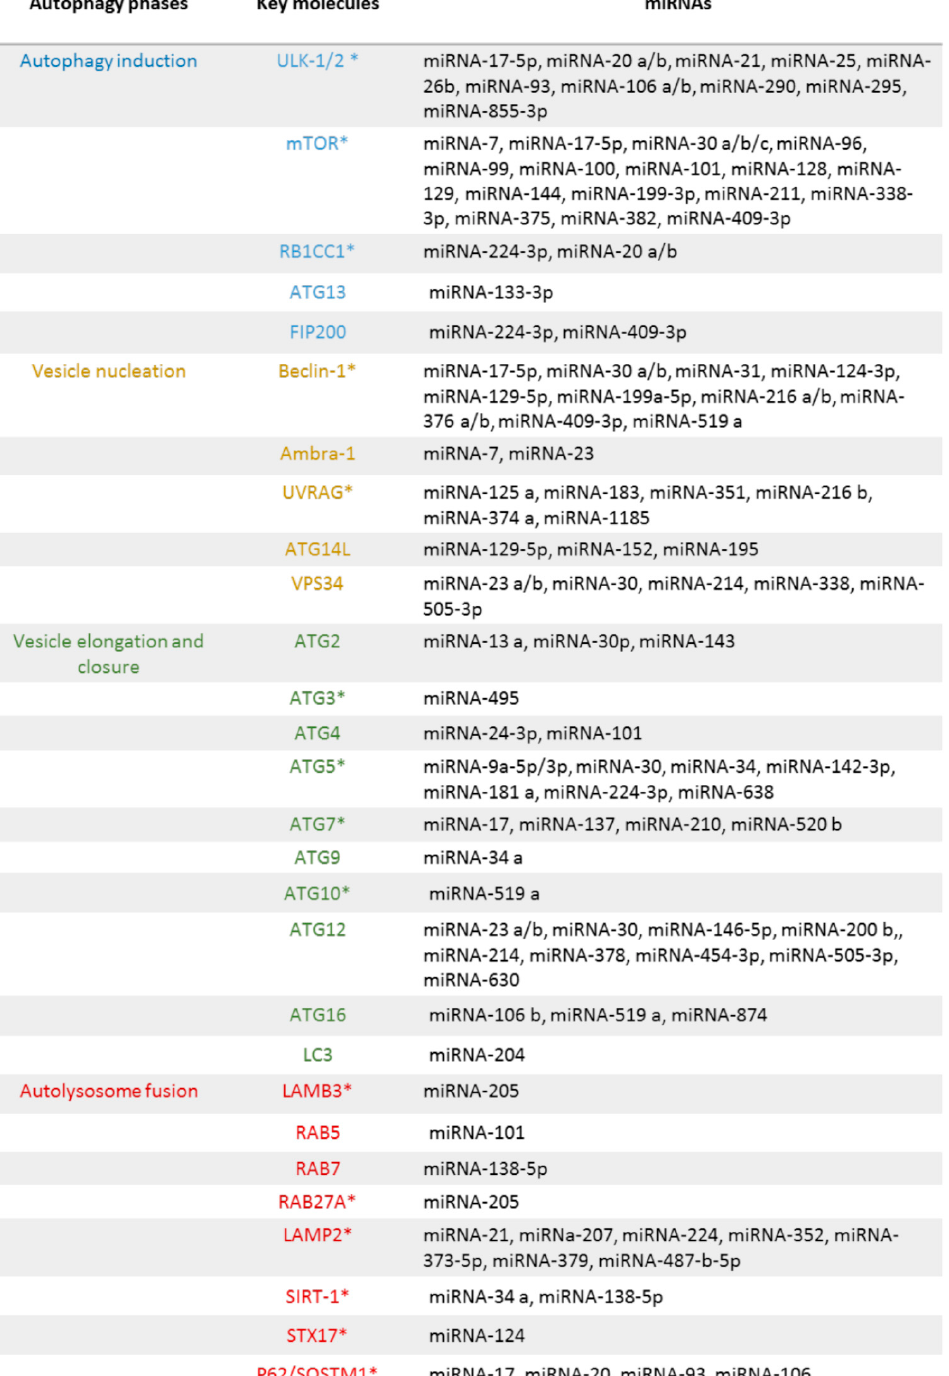
Figure 6. Regulation of outophagy by miRNA .